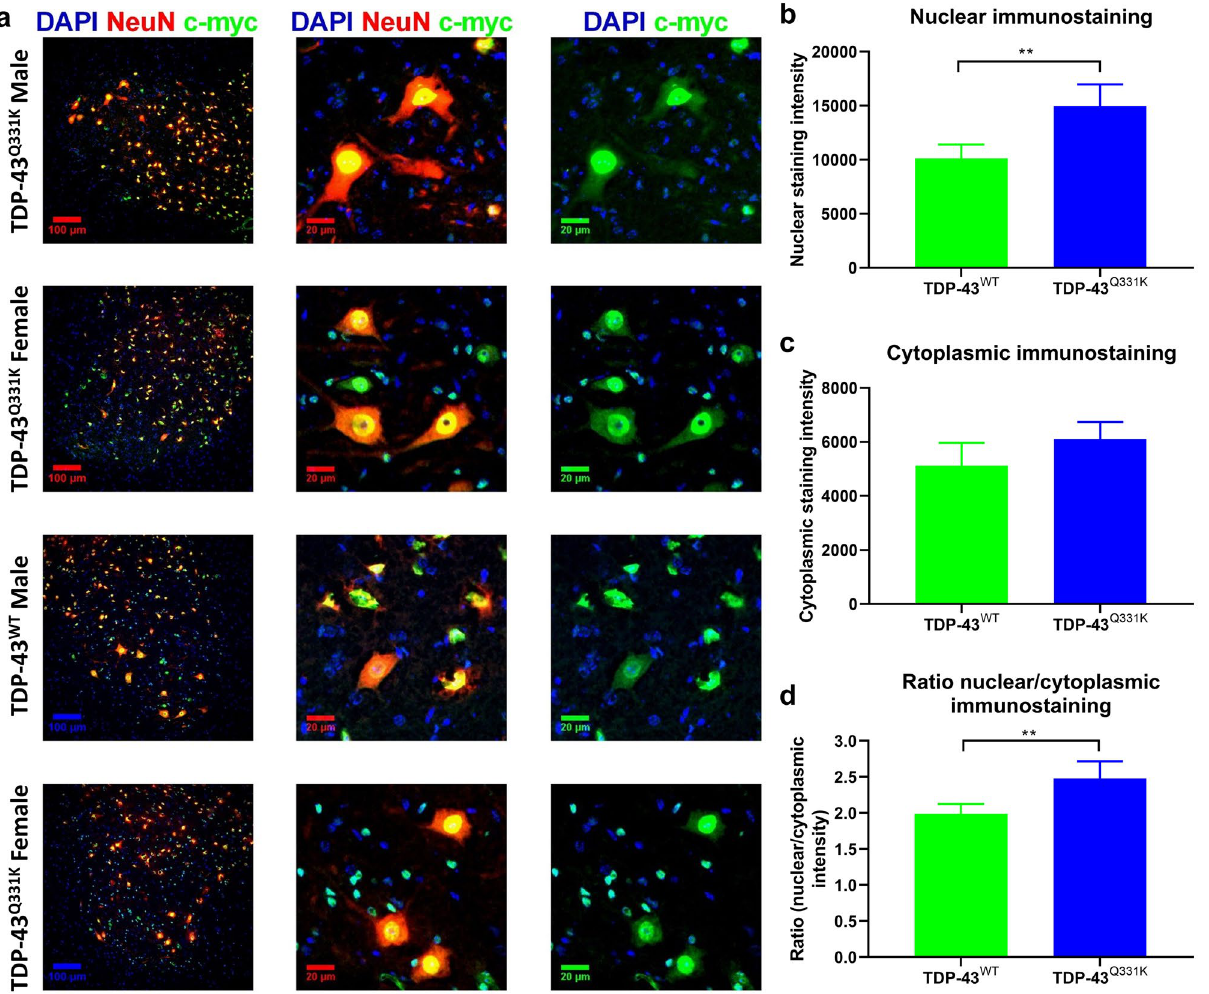
Figure 3. Immunohistochemical staining of lumbar spinal cord to detect human TDP-43. Immunohistochemical staining of DAPI, NeuN and c-myc in the lumbar ventral horns of 10 month old TDP- 43 WT and TDP-43 Q331K male and female mice (n = 5/group). Panels in ( A ) show example staining from one male TDP-43 Q331K , one male TDP-43 WT , one female TDP-43 Q331K and one female TDP-43 WT lumbar spinal cord. Scale bars are 100 µm (first column), and 20 µm (columns 2 and 3). Nuclear ( B ) and cytoplasmic ( C ) quantification using automated pixel intensity counting (± SD) of c-myc-tagged hTDP-43 in the lumbar cord. ( D ) Ratio of nuclear/cytoplasmic staining of c-myc-tagged hTDP-43. Error bars represent mean ± SD, one way ANOVA, ** = p < of nuclear/cytoplasmic staining intensity of c-myc-tagged TDP-43 was also significantly higher in TDP-43 Q331K motor neurons ( p < 0.01) (Fig. 3D). Human TARDBP transgene and TDP‑43 protein expression. The original report describing this model indicated that the level of expression of the introduced transgene and protein were not significantly dif- ferent between the TDP-43 Q331K and TDP-43 WT lines 22 . In order to compare the level of transgene expression between lines, human TDP-43 (huTDP-43) transcript levels were measured by RT-qPCR in the cortex, spinal cord and hindlimb muscles of TDP-43 Q331K and TDP-43 WT mice at 10 months of age (Fig. 4A–C). Expression of huTDP-43 transcripts was over threefold higher in the TDP-43 Q331K cortex compared to the TDP-43 WT cortex (308.4 ± 36.4% vs 100 ± 17.3%, p < 0.0001), twofold higher in the TDP-43 Q331K spinal cord compared to the TDP- 43 WT spinal cord (213.3 ± 65.8% vs 100 ± 13.3%, p < 0.0001), and fourfold higher in the TDP-43 Q331K hindlimb muscle compared to the TDP-43 WT hindlimb muscle (407.6 ± 111.9% vs 100 ± 19.8%, p < 0.0001). Western blotting with an anti-TDP-43 antibody allowed for quantification of both human and mouse TDP-43 protein due to the c-myc tag on the human protein increasing its molecular weight (Fig. 4D–F). Moderate levels of human TDP-43 were measured in the TDP-43 WT mice at 10 months of age (66.6 ± 21.0% in cortex, 126.1 ± 67.1% in spinal cord compared to endogenous mouse TDP-43), whilst levels in the TDP-43 Q331K mice were significantly higher than endogenous mouse TDP-43 in cortex (151 ± 56.5%, p < 0.001) but not in spinal cord (213.9 ± 154.1%).